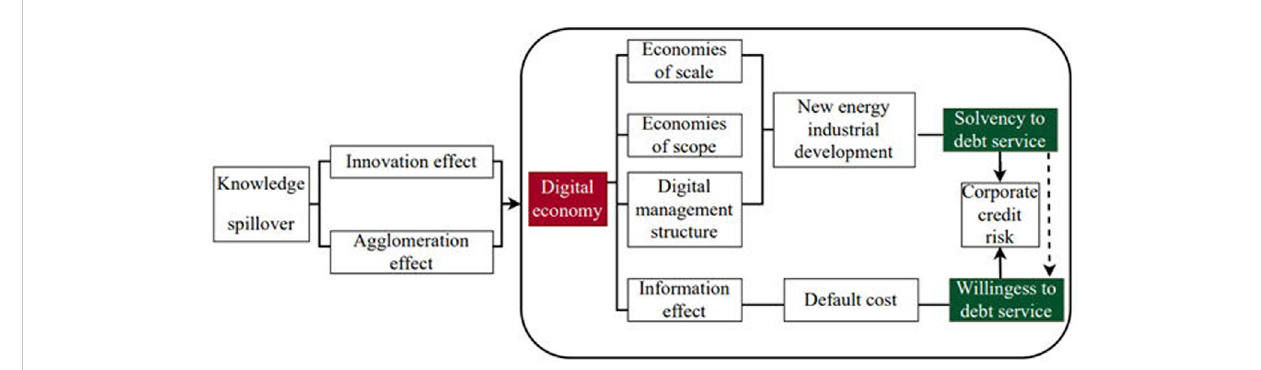
FIGURE 1 The theoretical framework of the digital economy, knowledge spillover, and corporate credit